Question: Produce a descriptive caption suitable for publication.
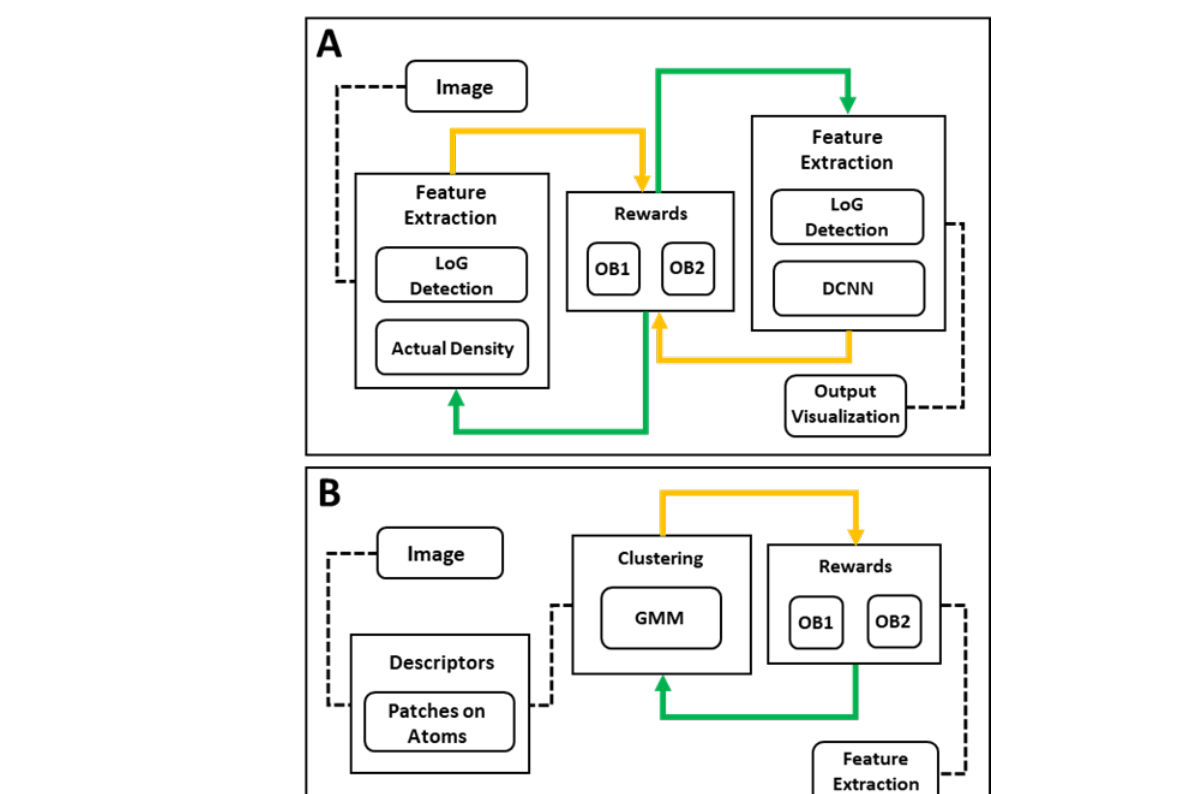
Answer: A) Workflow for reward-driven methodology in TEM images, Data preparation,  Optimization of the LoG function based on two objectives using Multi-objective Bayesian  Optimization, and Processing, B) Workflow for reward-driven methodology in TEM images, task  specified version.